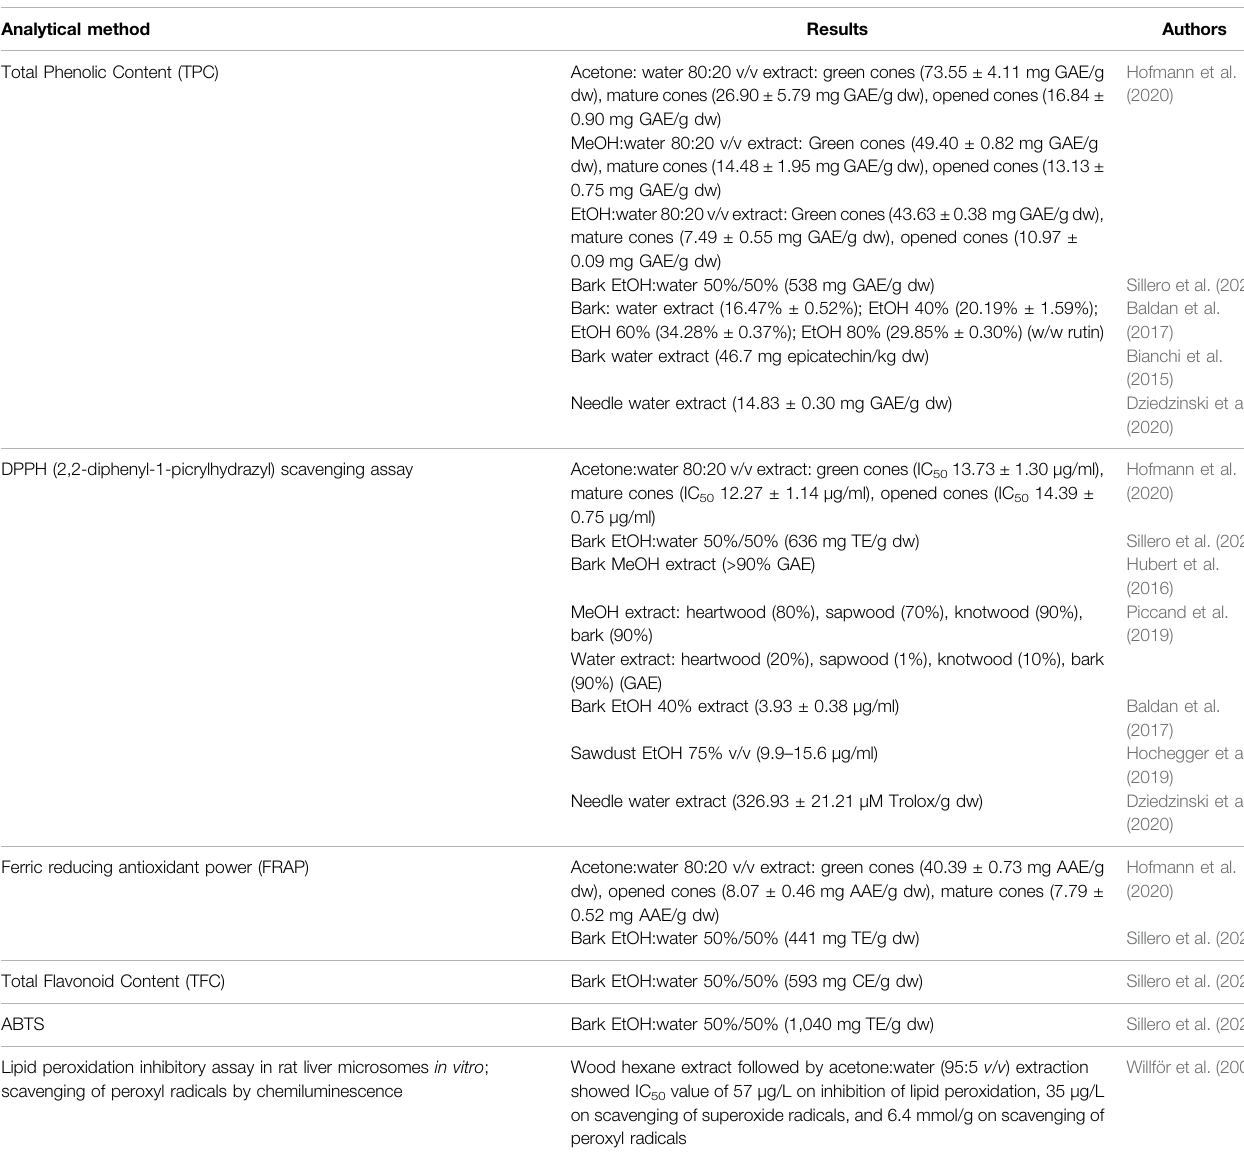
TABLE 5 | Antioxidant evaluation of Larix decidua Mill. [Pinaceae] extracts. Analytical